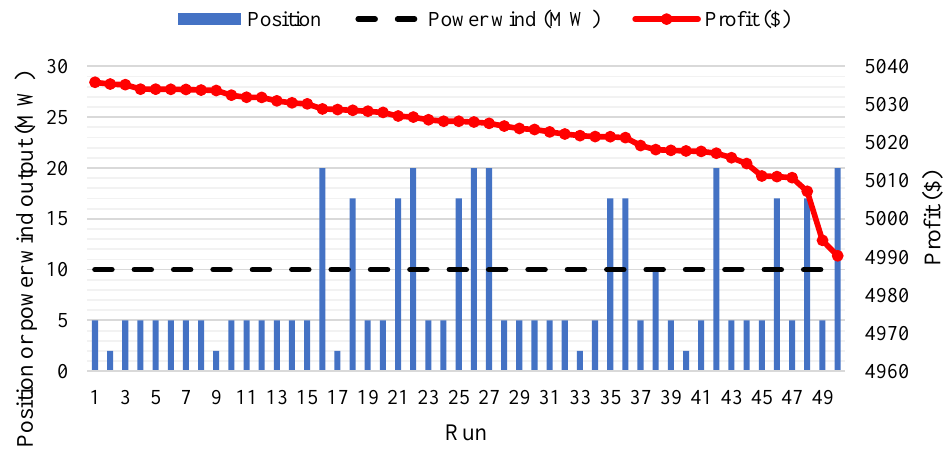
Figure 12. Optimal location and size of wind turbine obtained by JSA for 50 runs.